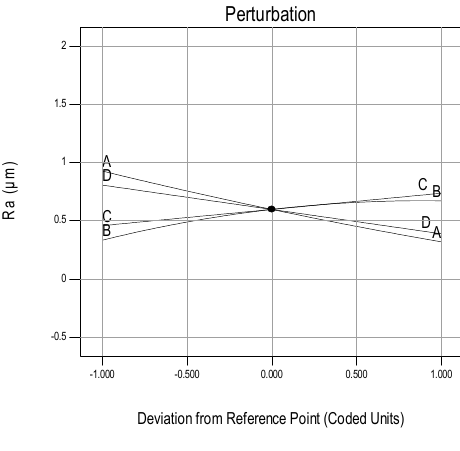
Fig. 3. Perturbation plot for